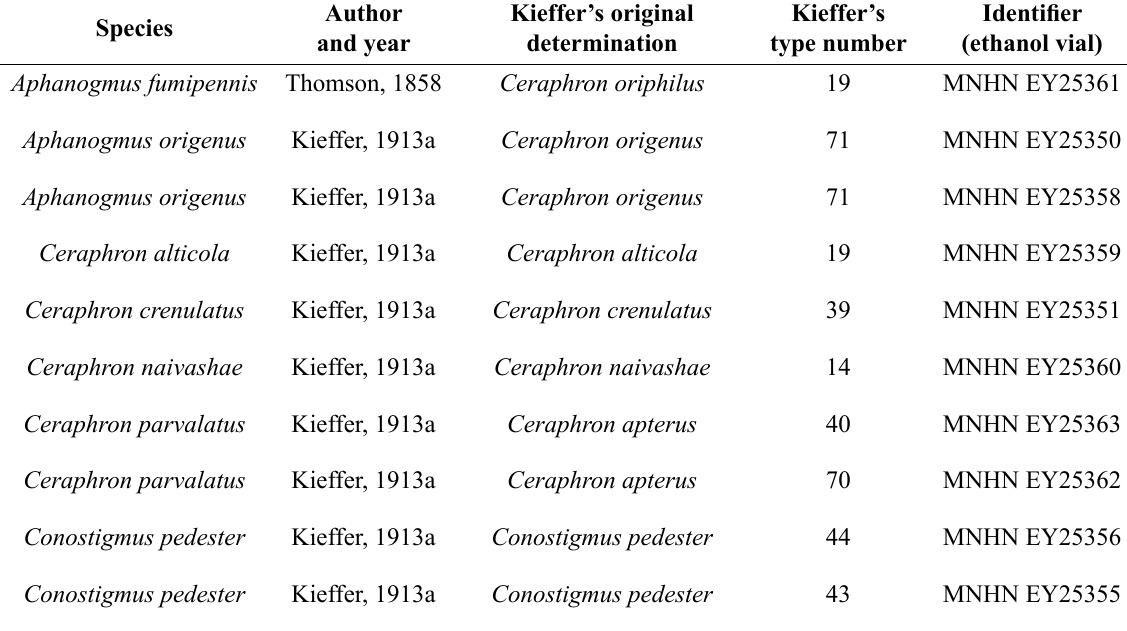
Table 3. A list of all kieffer specimens stored in ethanol at the Muséum national d’histoire naturelle, Paris (MNhN) and their associated type numbers assigned by